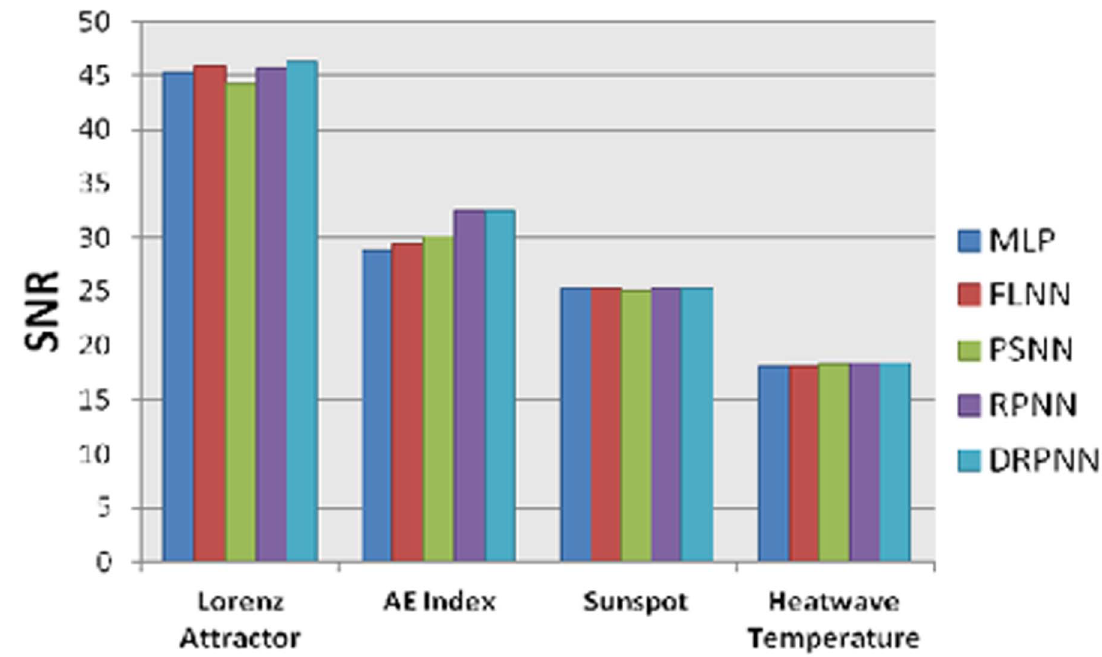
Figure 13. Best simulation result using the SNR.